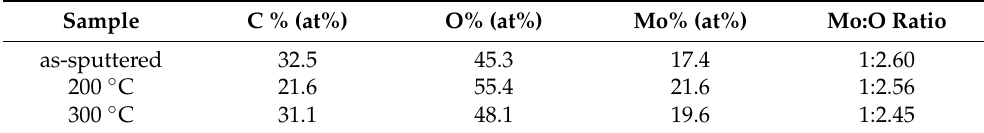
Table 1. Summary of the XPS data for the as-prepared and heat-treated samples.